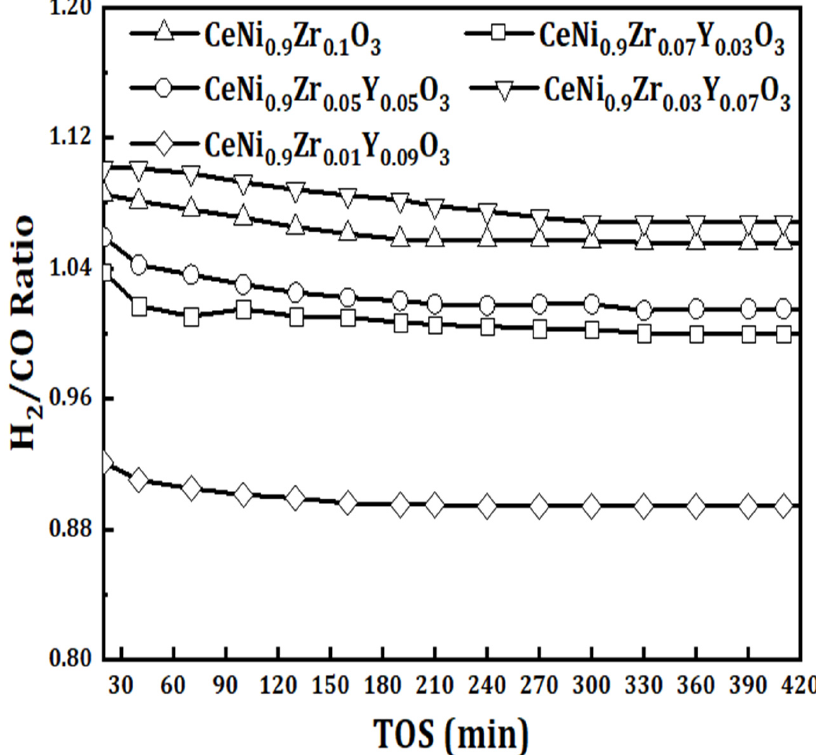
Figure 9. H 2 /CO ratio of perovskite catalysts CeNi 0.9 Zr 0 . 1 − x Y x O 3 (x = 0, 0.03, 0.05, 0.07, and 0.09) at 800 °C, 1 atmosphere and GHSV = 42 l/(h.g cat ).